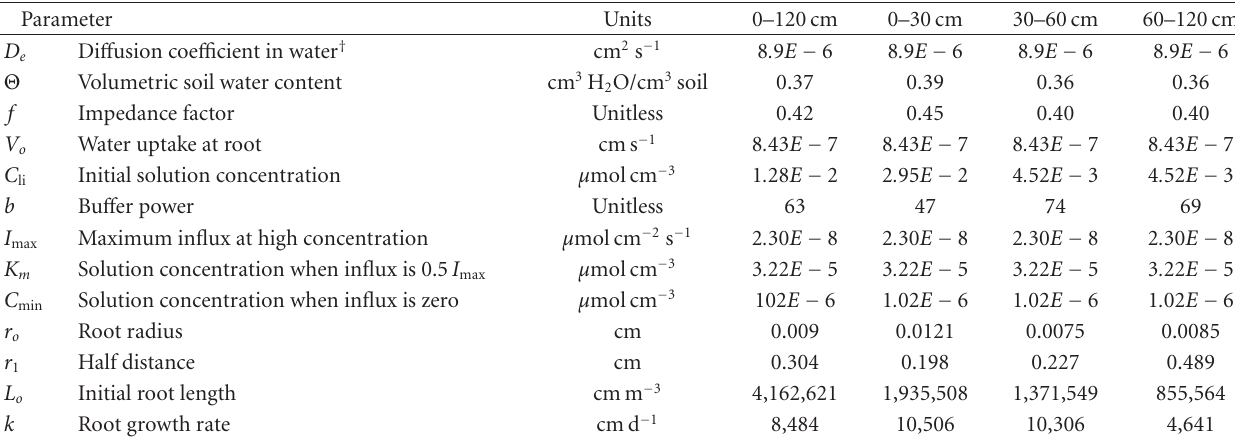
Table 2: Transport, sorption, and root parameters used in the NST 3.0 model to describe P uptake by switchgrass for the 0–120, 0–30, 30–60, and 60–120 cm soil depths.